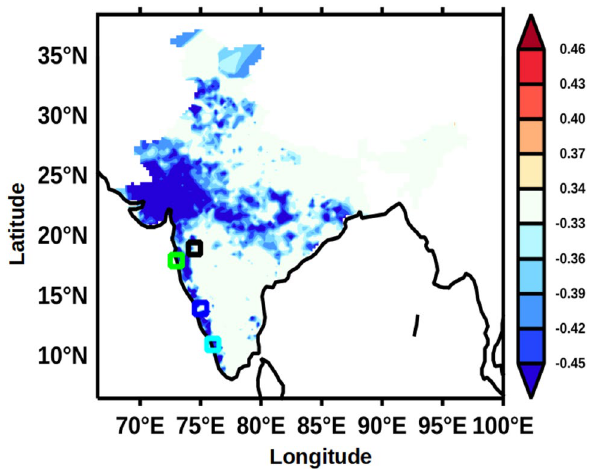
Figure 9. Anomaly correlation of WSC averaged during JJAS within the box region (50–70°E and 4–12°N, see Fig. 1) with rainfall averaged for the same months in the Indian sub-continent. The blue colour represents the significant negative correlation value at 95% confidence. The small squares of different colours represent the location of sub-divisonal stations, Madhya Maharashtra (black), Konkan (green), Coastal Karnataka (blue), and Kerala